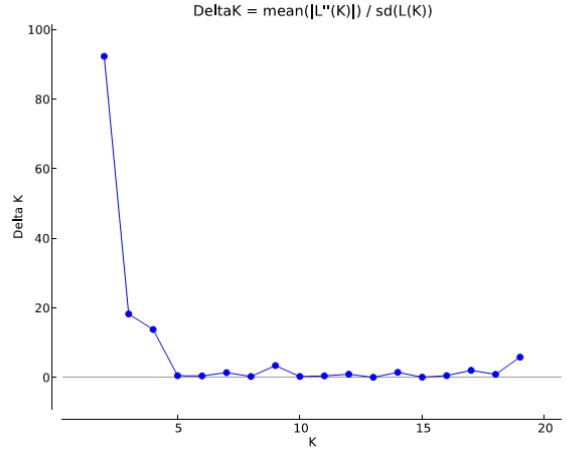
Figure 3. Estimates of the rate of the slope of the log probability curve ( ∆ K ) plotted against K .